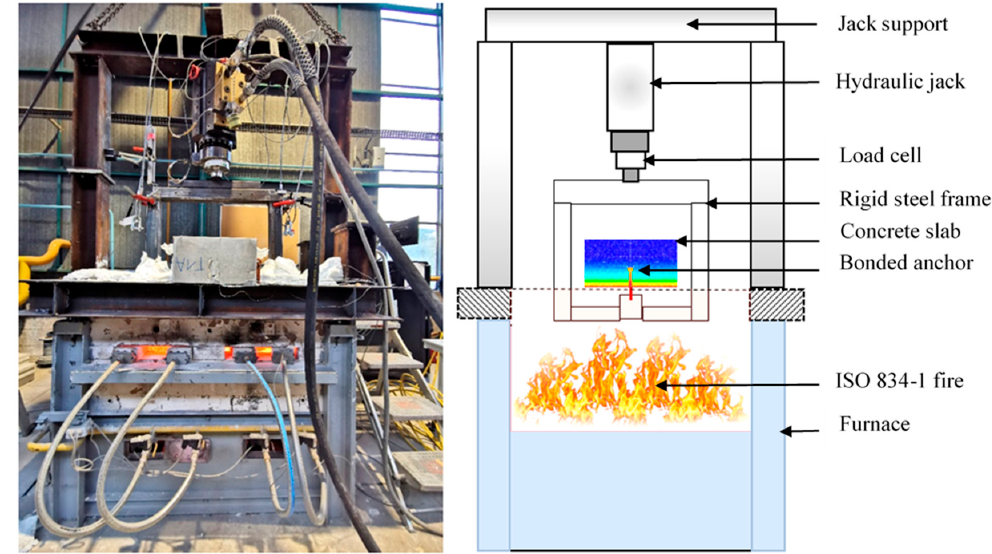
Figure 3. Setup for standard ISO 834-1 fire